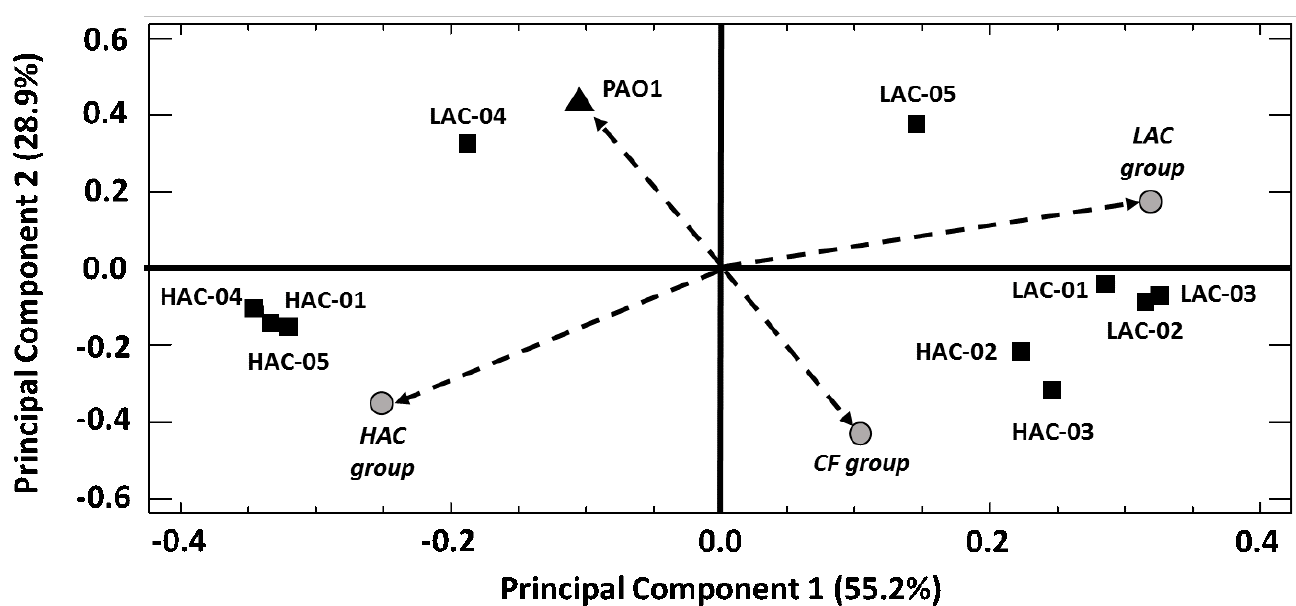
Figure 2. Principal component analysis (PCA) of the experimental and in silico phospholipidomes of the Pseudomonas aeruginosa strains. The mean experimental phospholipidome (filled black symbols) of Pseudomonas aeruginosa PAO1, a collection strain ( ▲ ), was calculated from eight biological replicates. In a similar manner, phospholipidomes of 10 cystic fibrosis (CF) clinical strains ( ■ ) were obtained for the 5 CF strains exhibiting the lowest attachment capacities (LAC-01 to -05) and the 5 CF strains with the highest attachment capacities (HAC-01 to -05). In silico phospholipidomes (filled gray circles) were determined from experimental data obtained for all CF strains (CF group), LAC strains (LAC group) or HAC strains (HAC group). The phospholipids were quantified as detailed in the Materials and Methods section. The component plot was obtained via Statgraphic Plus 5.1 software using the PCA matrix presented in Table S1 (see “PCA”). 9. Differences among the Phospholipidomes of the P. aeruginosa Clinical Strains